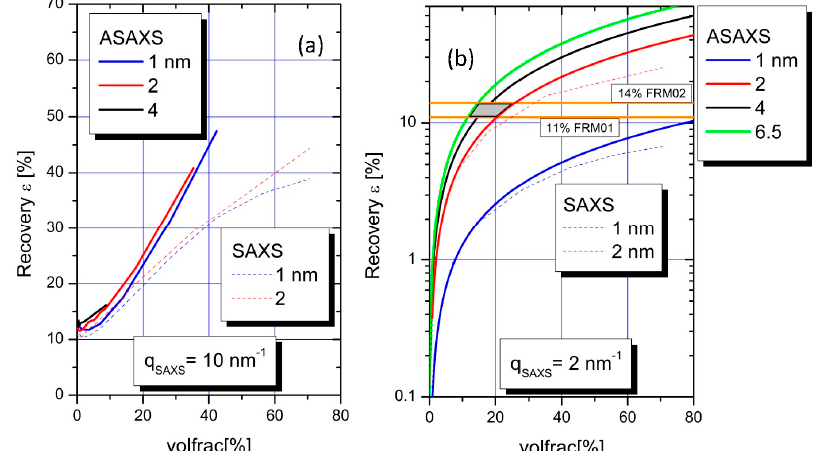
Figure 5. Two integrals of normalized ASAXS and SAXS Kratky plots have been calculated for four different cubic confinements (1, 2, 4, and 6.5 nm) under the condition of a standard small-angle scattering experiment over the two integration intervals 0< q < 10 nm − 1 ( a ) and 0< q < 2 nm − 1 ( b ). The grey parallelogram represents the area of small confinements with low filling degrees compatible with results from the RI-analysis and XANES (see text).